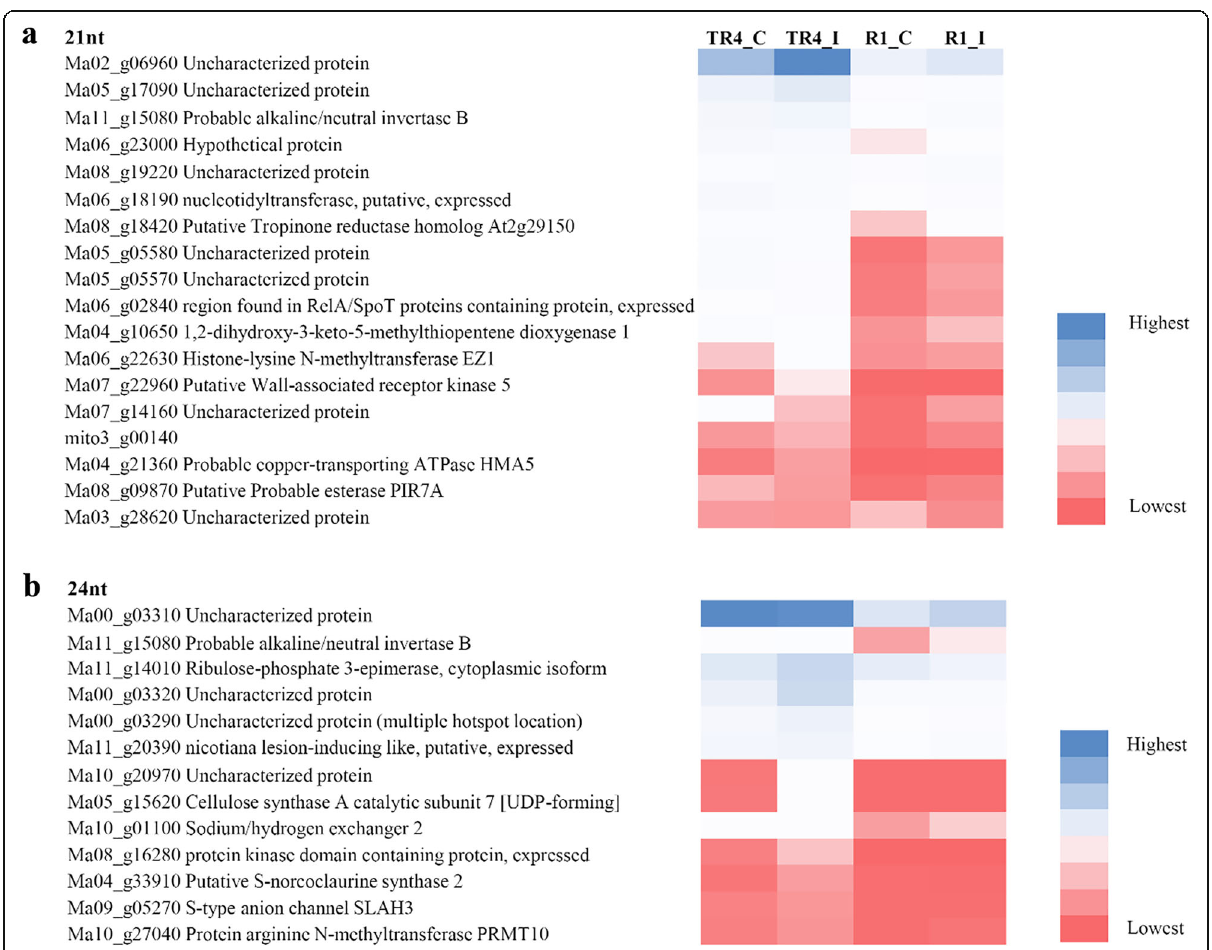
Fig. 7 Increased abundance of the reads mapping to some banana genes was observed in inoculated samples as compared to control. a 21 nt mapped reads. b 24 nt mapped reads. Banana genes with annotated protein name were listed in the left column. The four columns on the right represent the abundance of mapped reads from respective treatment group. The darkest blue color represents the highest mapped read count, and the darkest pink color represents the lowest mapped read count. Exact read count is listed in Additional file 4: Table